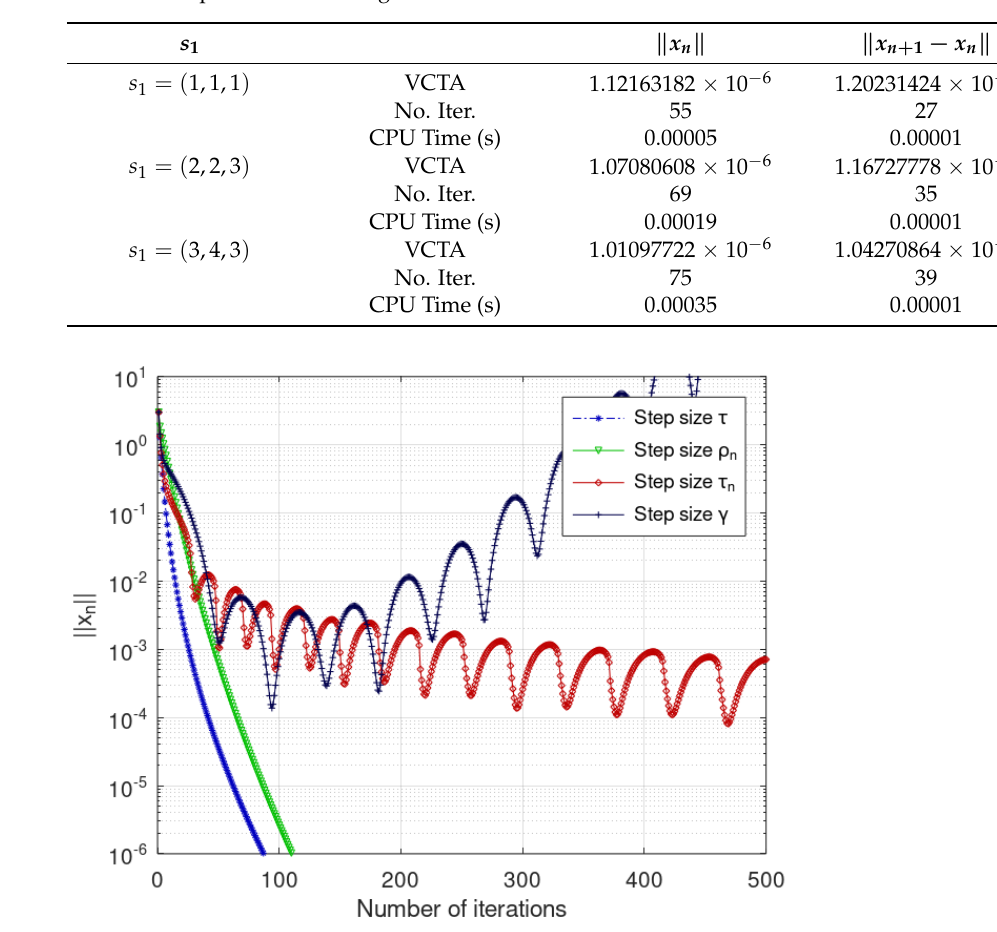
Figure 3. Comparison of (cid:107) x n (cid:107) for different step